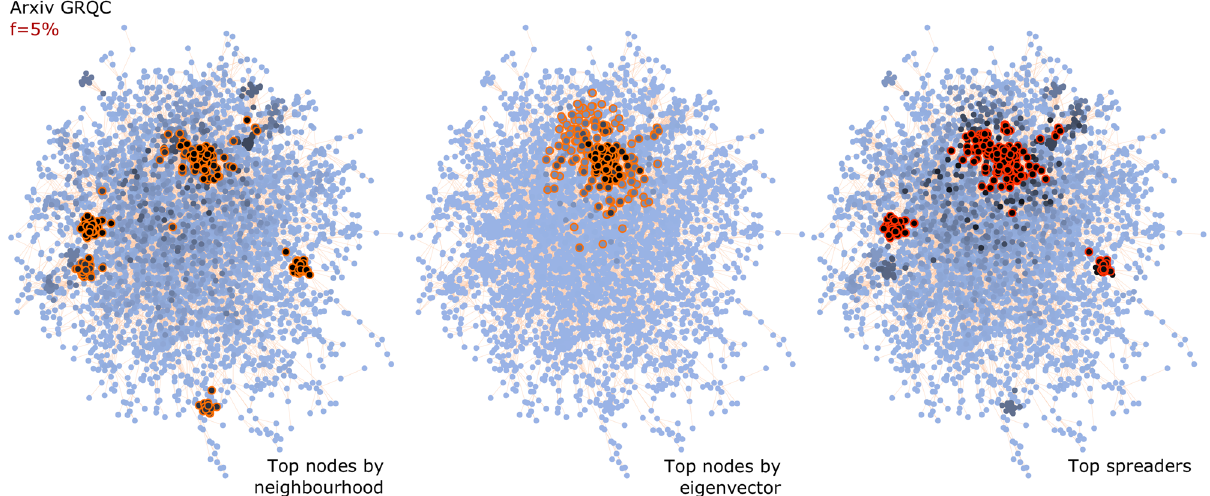
Figure 1. Comparing the location of the top nodes as ranked by (left) neighbourhood size, (centre) eigenvector centrality, and (right) SIR spread size at the epidemic threshold for the coauthorship network Arxiv GRQC. The network layout is force-directed. The colour of the nodes in each panel shows the value of that metric: darker nodes have higher centrality values or spread size. The top f = 5% of the nodes in each case are